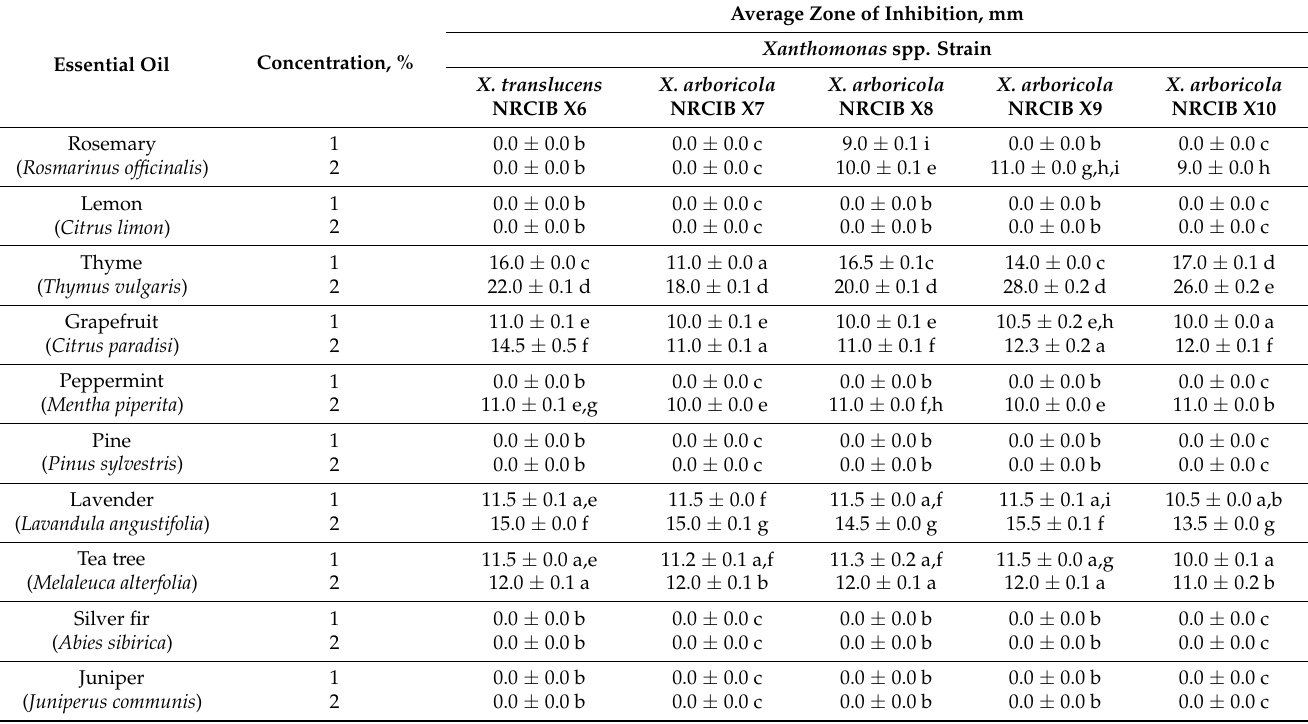
Table 3. Antibacterial effect of essential oils on Xanthomonas spp.